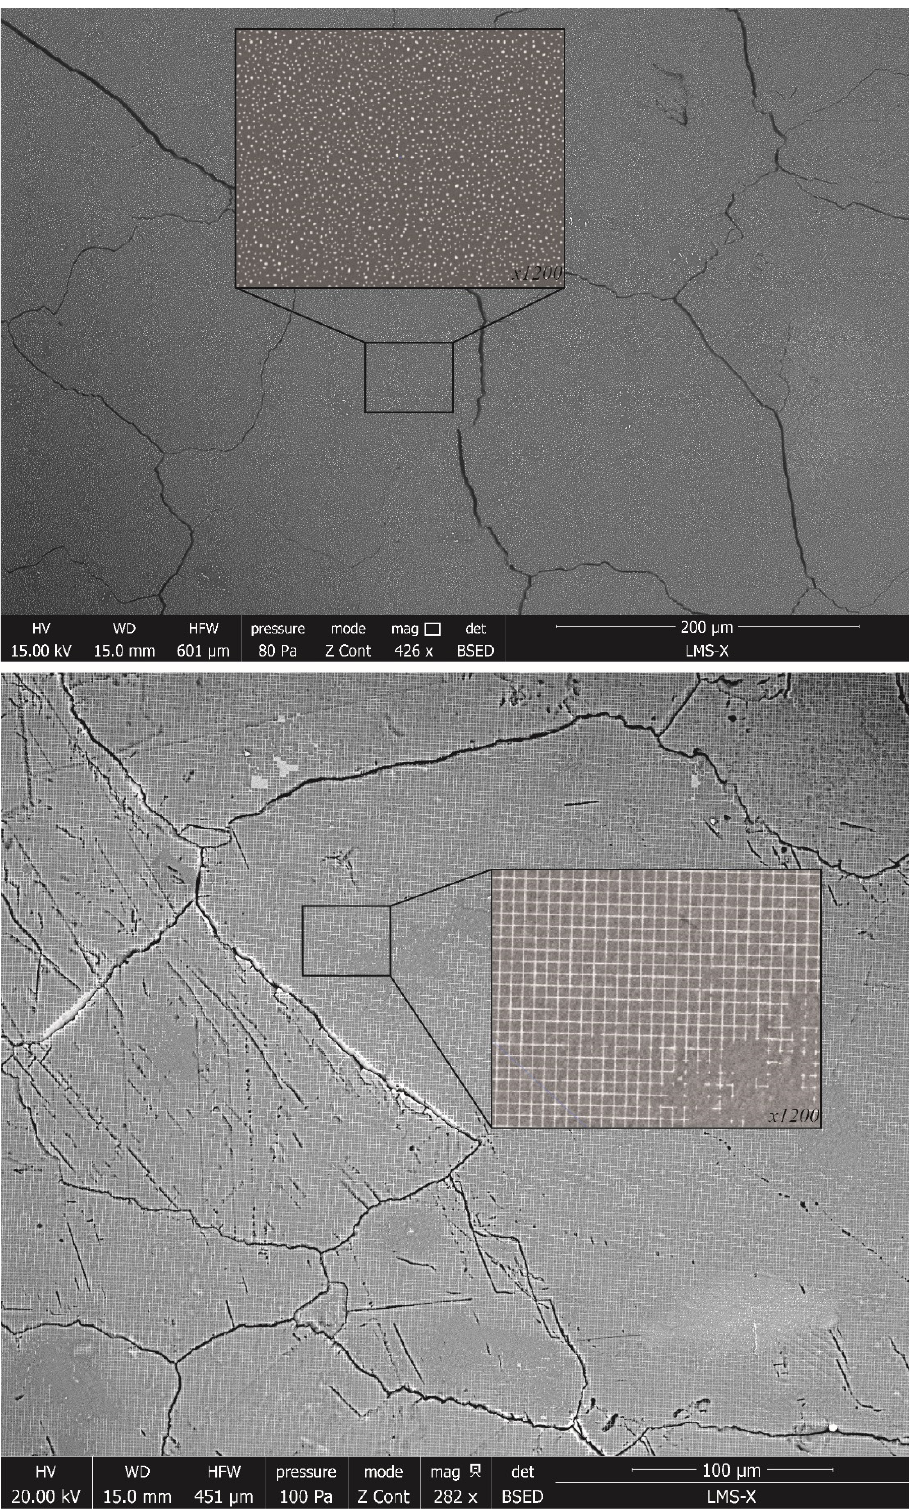
Figure 2. SEM photograph of Carrara marble samples with gold marking of the surface. ( The top photograph ) shows the result of the gold dewetting protocol. ( The second photograph ) illustrates the result of marking using the lithography technique.